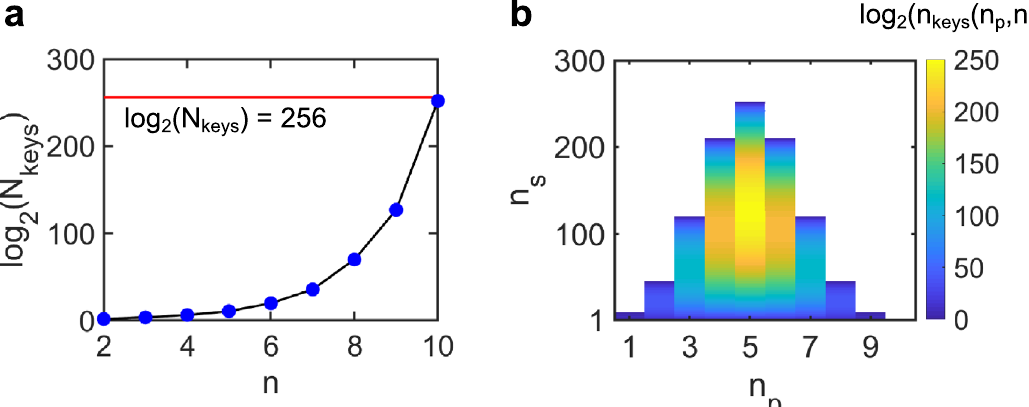
Figure 3. Size of the key space. (a) Variation of log 2 ( N keys ) with n . The solid red line shows the AES limit of N keys = 2 256 for symmetric encryption. ( b) Variation of log 2 ( n keys ) with n p and n s for n =